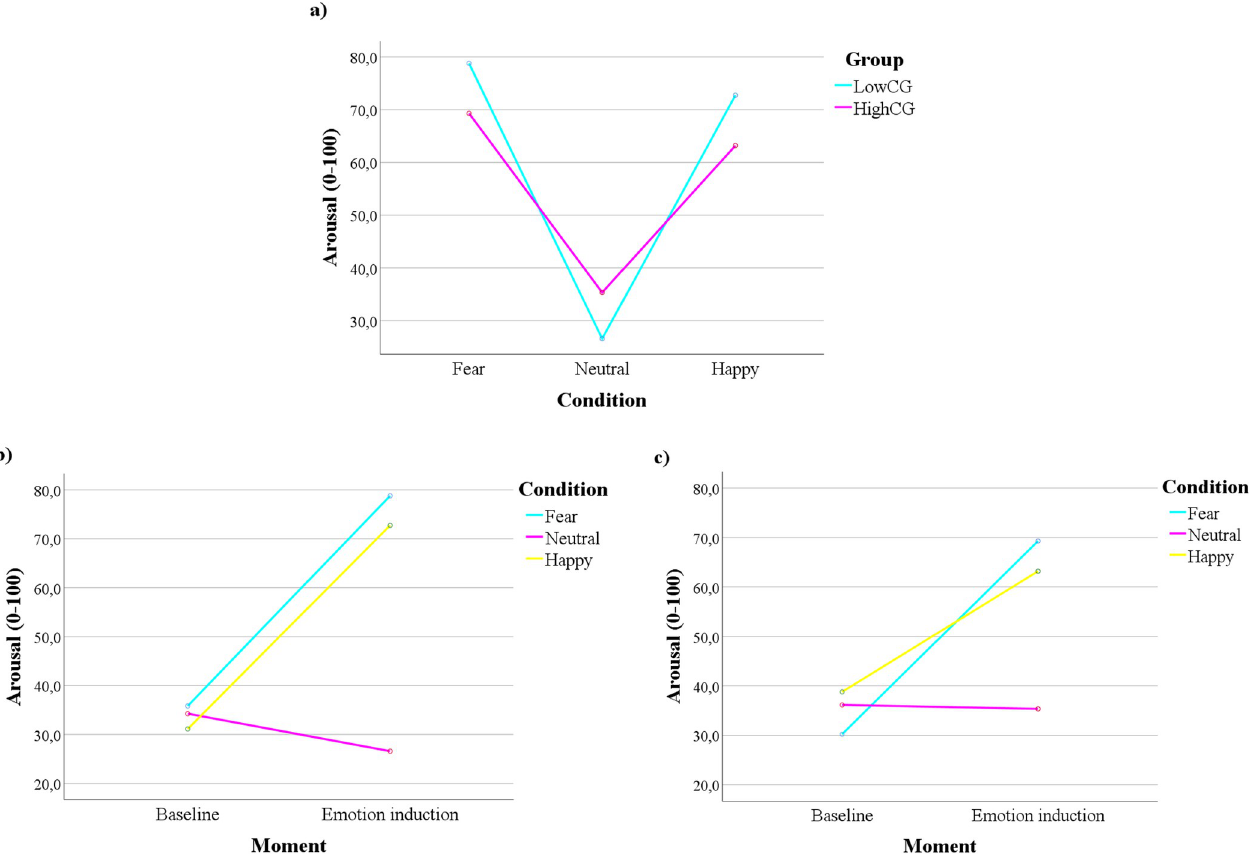
Fig 1. Cognitive groups’ differences regarding the self-reported arousal. a) Group differences in the self-reported arousal after the emotional induction; b) LowCG self-reported arousal across Moment and Condition; c) HighCG self-reported arousal across Moment and